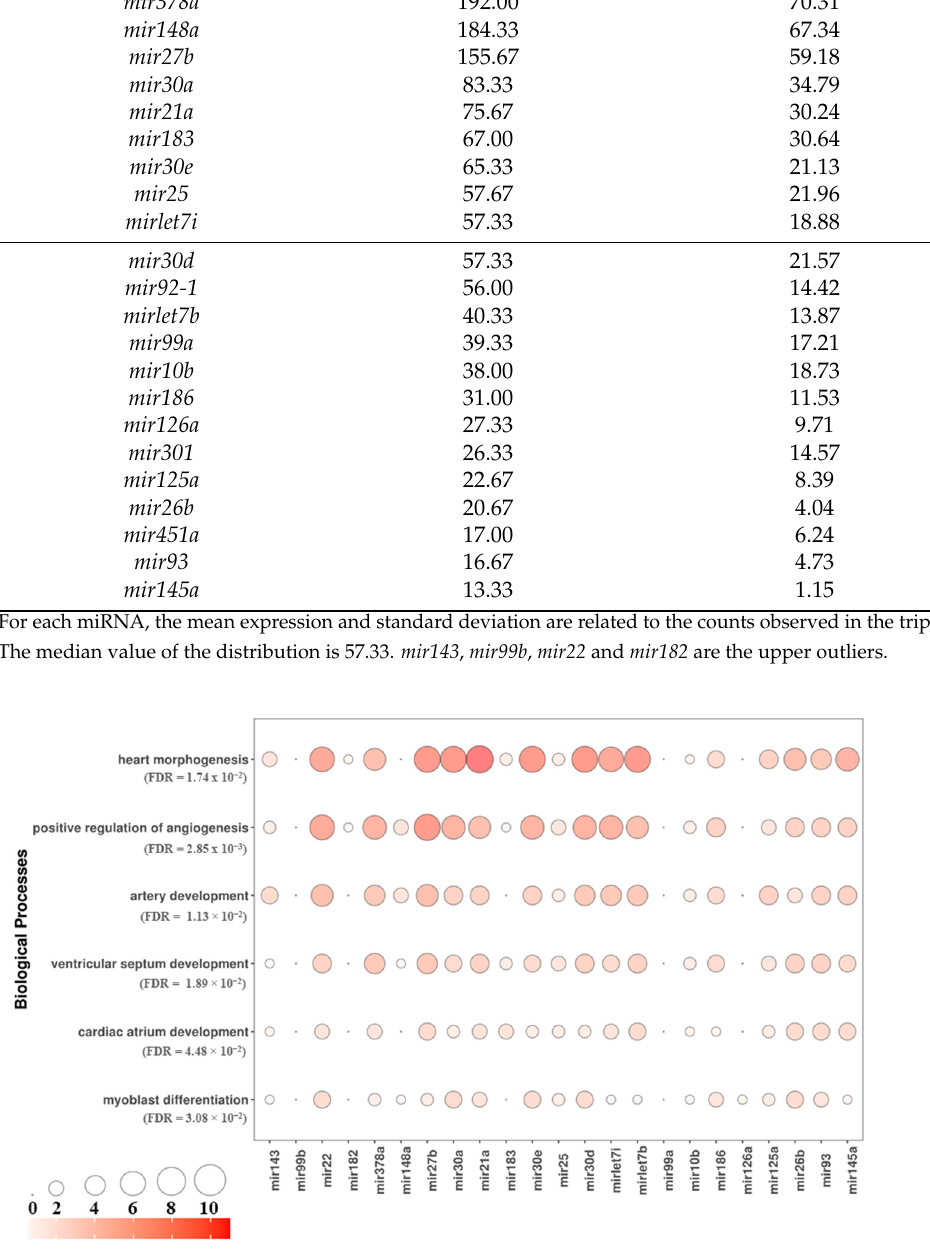
Figure 3. Bubbleplot of the biological processes related to myogenesis that characterizes the target genes of the miRNAs expressed in HL-1 vesicles. For each of the six biological processes that are showed on the rows, the significance value obtained with Panther (FDR) was highlighted and the number of genes that are targeted by the miRNAs in each column were shown. The miRNAs are sorted by expression level (from the left to the right). The white-red scale and the circles size show the number of target genes in the process (in order from the least to the most).